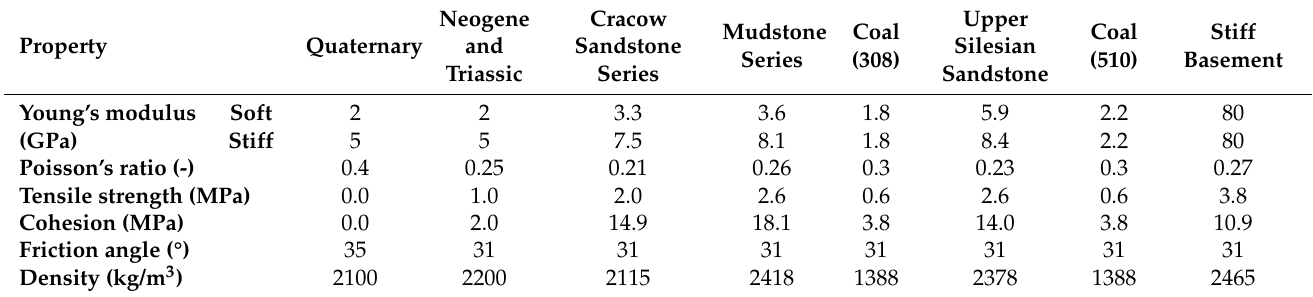
Table 3. Geomechanical parameters used for the undertaken scenario